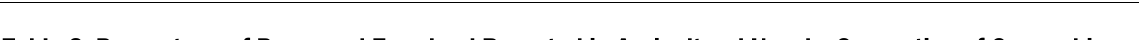
Table 2. Percentage of Preserved Farmland Reported in Agricultural Use, by Generation of